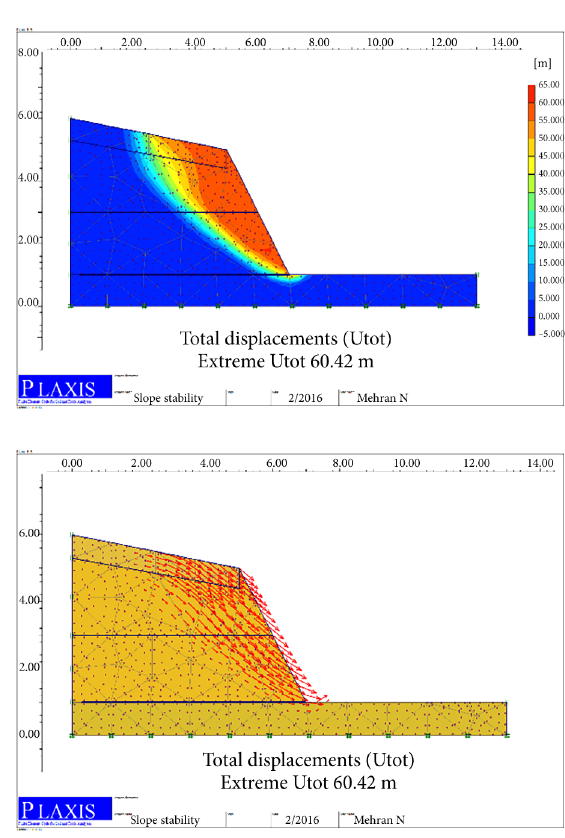
Figure 7. Modeling slope stability for 15-years-old trees by applying ML soil characteristics (the figures indicate stability analysis and orientation of forces from top to down, respectively)